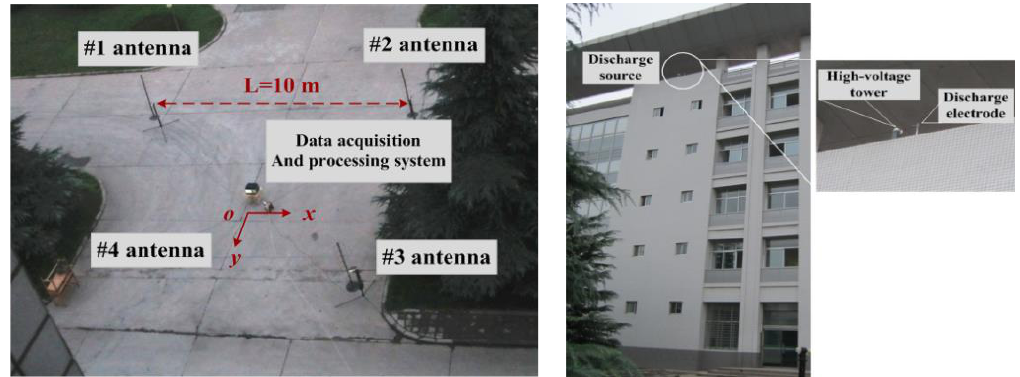
Figure 9. Arrangement of discharge source location at measurement point P1.